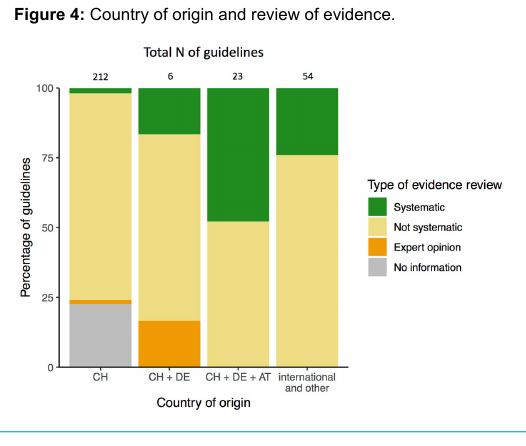
Figure 4: Country of origin and review of